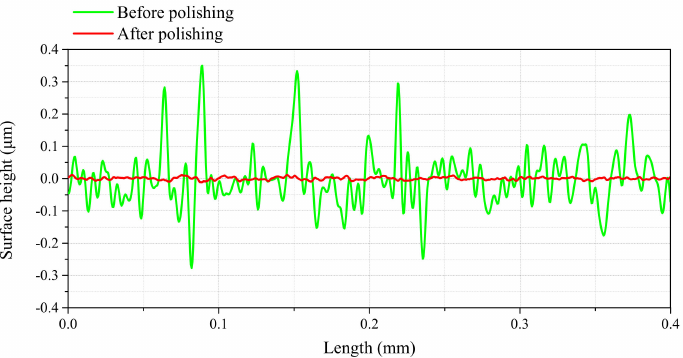
Figure 6. The contour curve of Ti-6Al-4V workpiece surface before and after